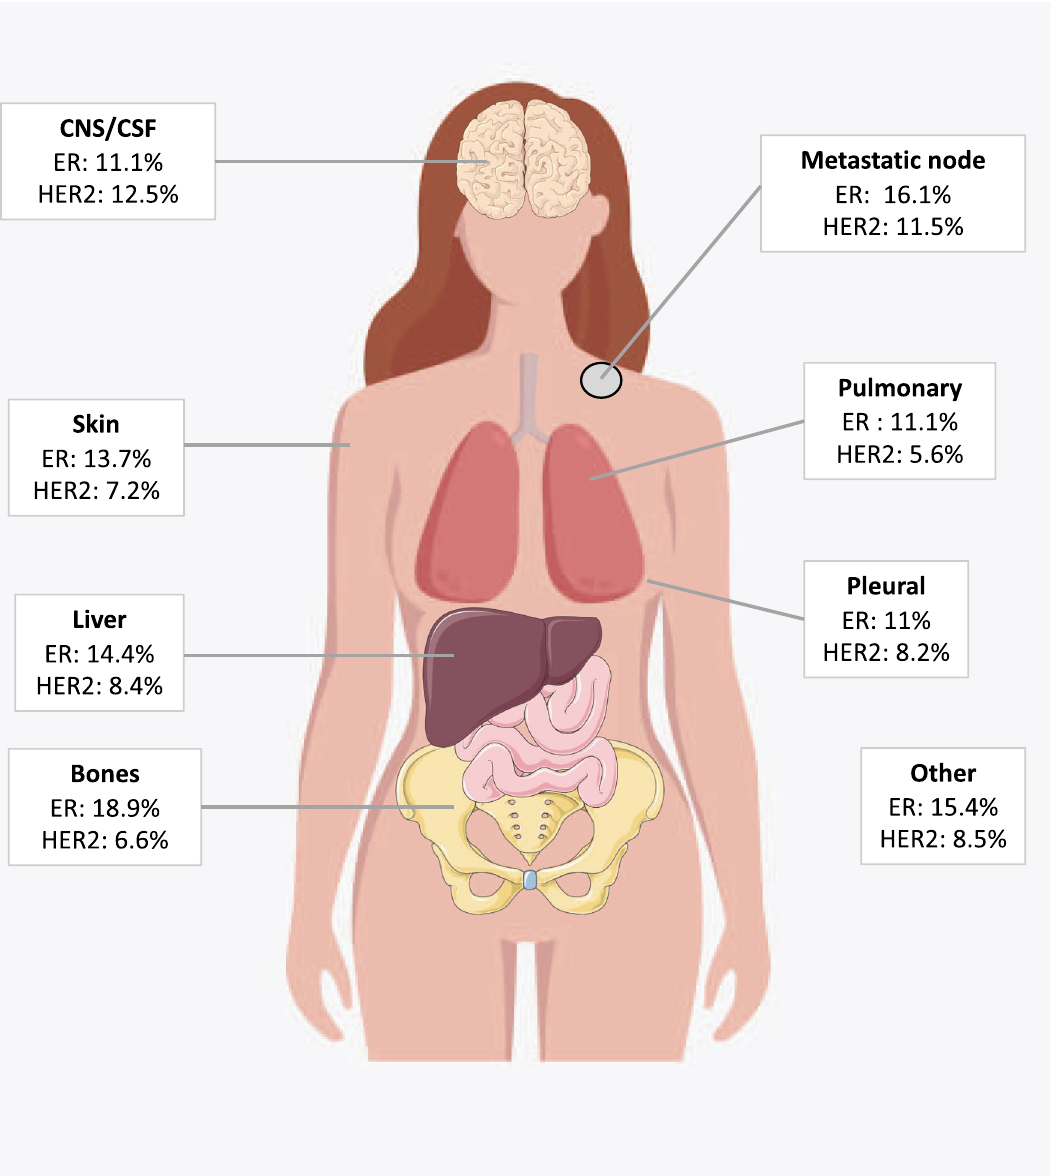
Fig. 4 Phenotypic discordance by metastatic site. CNS central nervous system, CSF cerebro-spinal fl uid, ER Estrogen receptor expression change, HER2 human epidermal growth factor receptor 2 expression